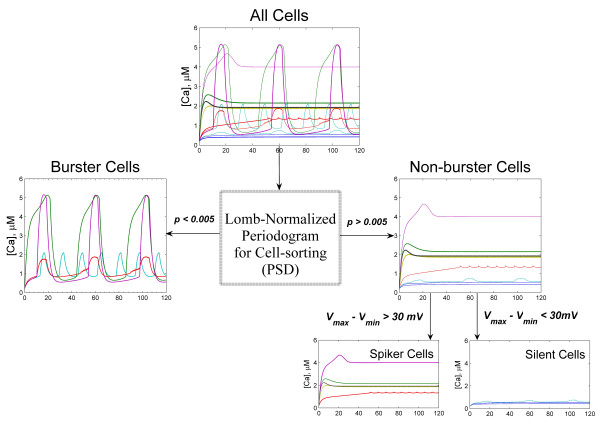
The flowchart of our cell sorting algorithm. Intra-cellular calcium signals, Ca(t) are passed to a program which calculates the periodogram PSD and the probability of the peak PSD values. If p < 0.005, cell is sorted as a burster cell. Among non-bursters, cells which satisfy the condition ΔV = |Vmax - Vmin| < 30 mV are considered silent cells, and the rest as spiker cells.